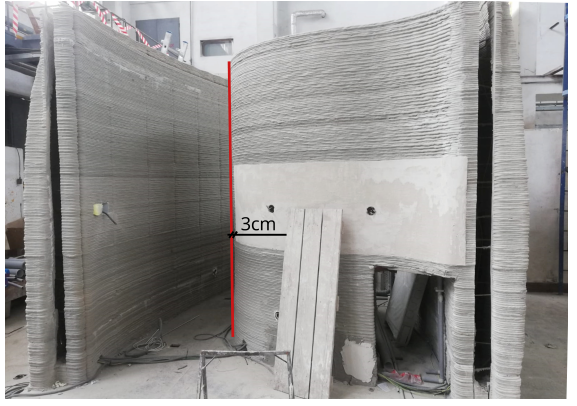
Figure 4. Buckling of the 3 meter high